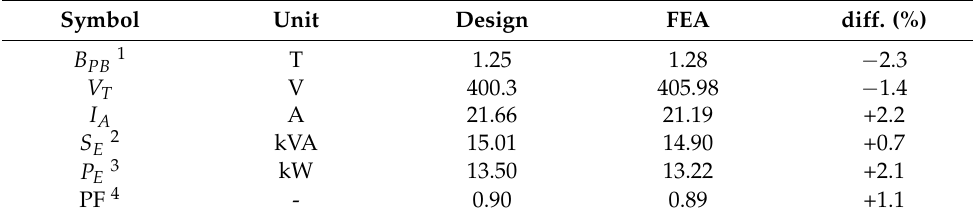
Table 6. Main electromagnetic